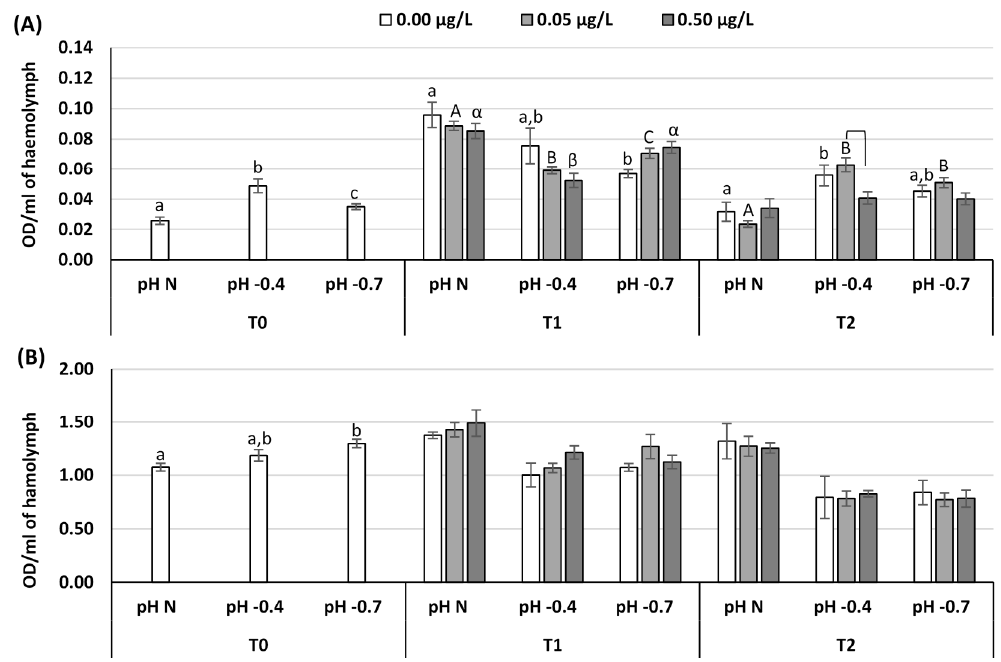
Figure 3. Hemocyte NR uptake ( A ) and hemocyte proliferation ( B ) in M. galloprovincialis . Values are the means ± SE (n = 6). Columns are white for 0.00 µg/L caffeine concentration, light grey for 0.05 µg/L caffeine concentration and dark grey for 0.50 µg/L caffeine concentration. Significant differences (p < 0.05) among treatments are shown at T1 and T2 only when a significant effect of the pH*diclofenac interaction was found. Differences among pH N, pH -0.4 and pH -0.7 at the same caffeine concentration are presented with lower-case letters (a–c) at the caffeine concentration of 0.00 µg/L, with capital letters (A–C) at the caffeine concentration 0.05 µg/L and with Greek letters ( α – β ) at the caffeine concentration of 0.50 µg/L. At each pH value, asterisks represent significant biomarker variations between different caffeine concentrations.